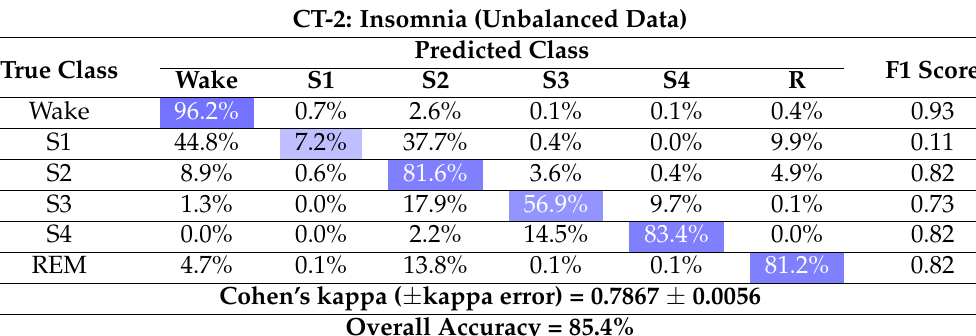
Table 11. Confusion matrix corresponding to sleep stage classification of insomnia patients with balanced data using the EBT classifier with 10-fold